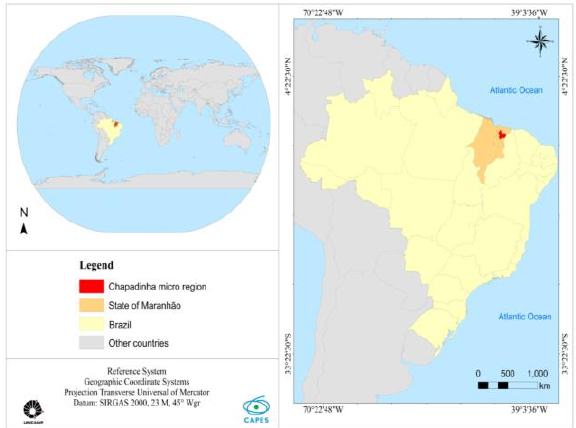
Figure 1. Location of the Chapadinha microregion in the Maranhão State. Source: adapted from IBGE (2019).